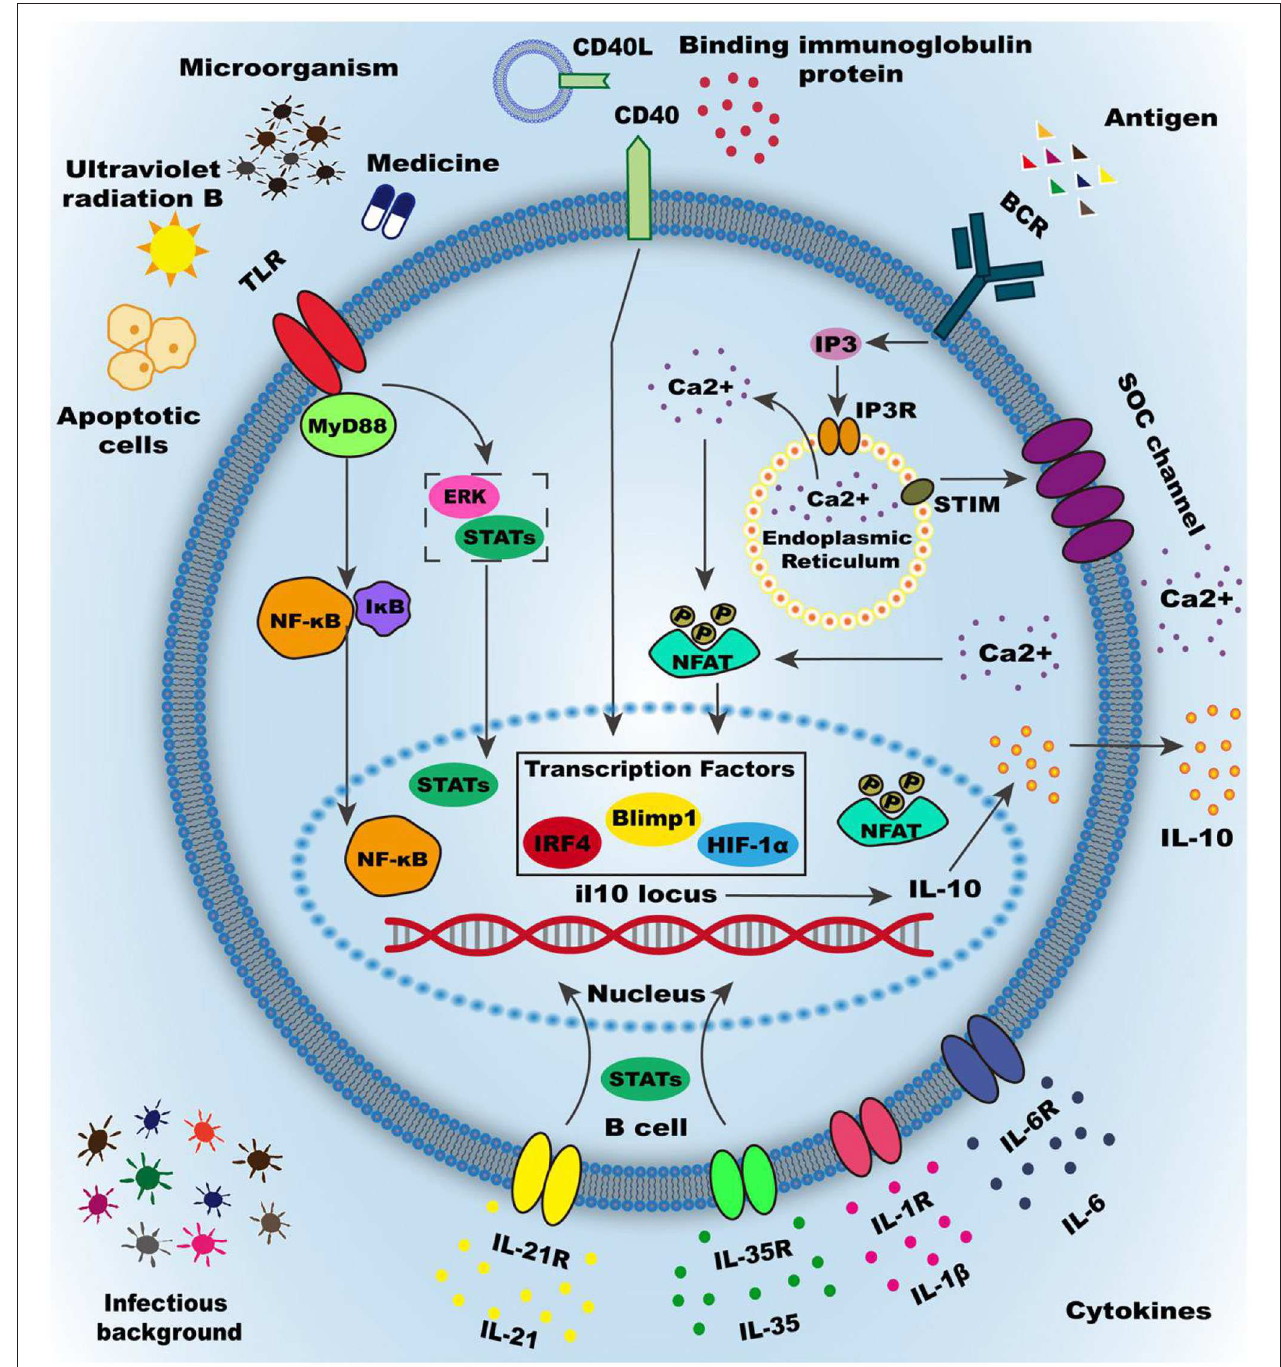
FIGURE 2 | Activation of Breg cells. Numerous mechanisms have been demonstrated to induce Breg cells, the most important of which are summarized as the inflammatory micro-environment and intercellular interactions. The inflammatory microenvironment is mainly produced by inflammatory factors, such as IL-35, IL-21, and other inflammatory cytokines. Cytokines often mediate activation of downstream signaling pathways by binding to cytokine receptors on the membrane. Microorganisms infection is another essential part of the inflammatory environment in the body, including invasive bacteria and commensal microbiota. Most microbial infections are activated by downstream molecular pathways mediated by membrane surface molecules, causing IL-10 transcription and translation and secretion. Intercellular interactions play a vital role in the induction of regulatory B cells, such as apoptotic cells or type3 innate lymphoid cells. Intercellular interactions mainly depend on the interaction of molecules on the surface of the membrane and the most classic surface molecules are Toll-like receptors (TLRs), CD40, B cell receptor (BCR). Many environmental and pharmaceutical factors can activate TLRs and cause downstream pathways activation, such as STATs and ERK orMyD88-NF- κ